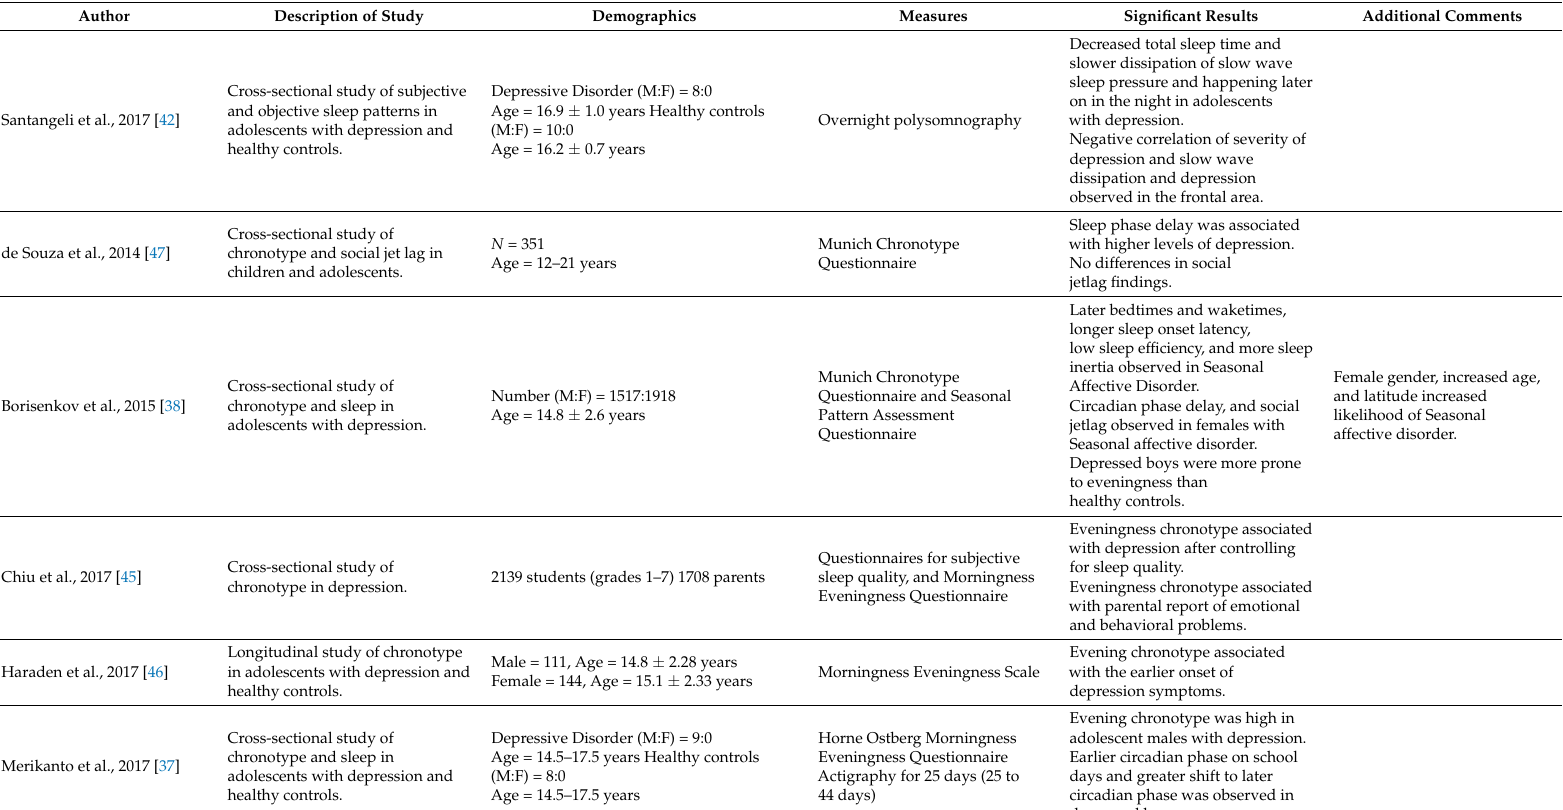
adolescents with depression and healthy controls.